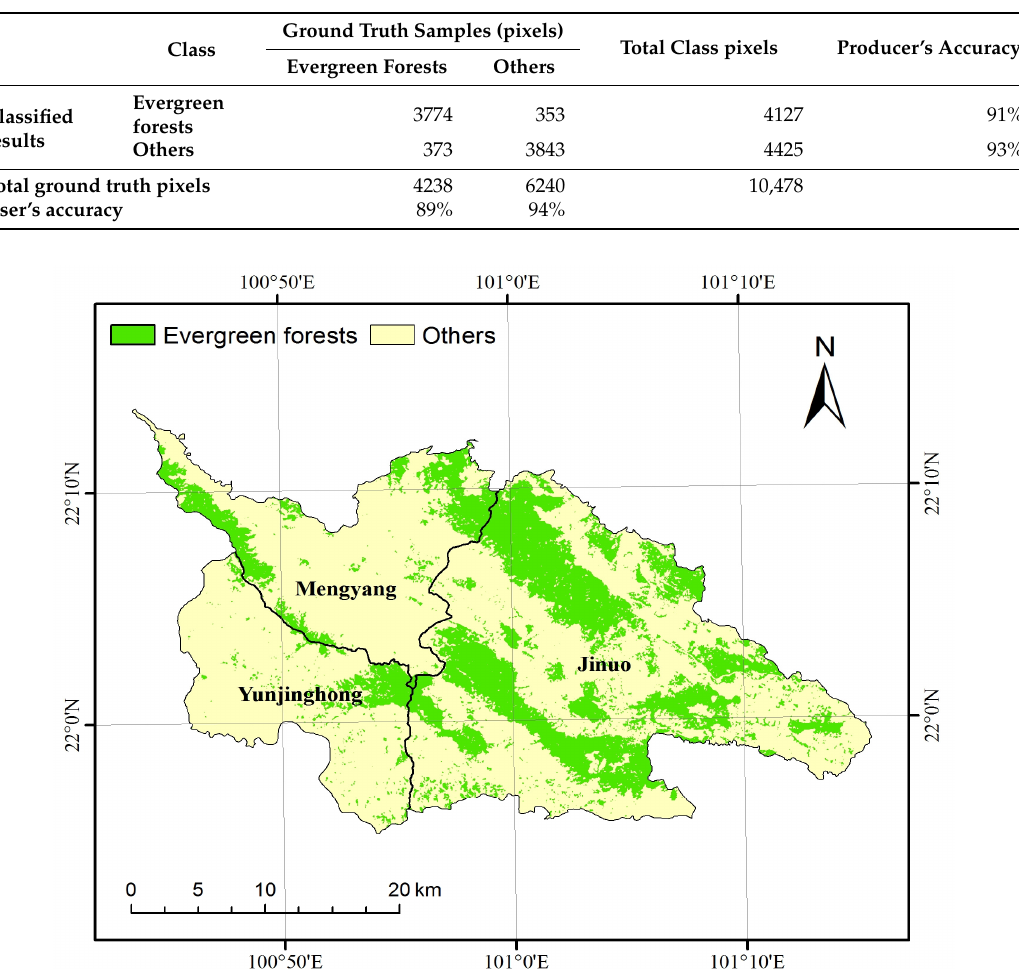
Table 3. The accuracy assessment result of the tropical evergreen forest resultant map at 30-m spatial resolution in 2010 based on an error matrix. The overall accuracy is 92%.